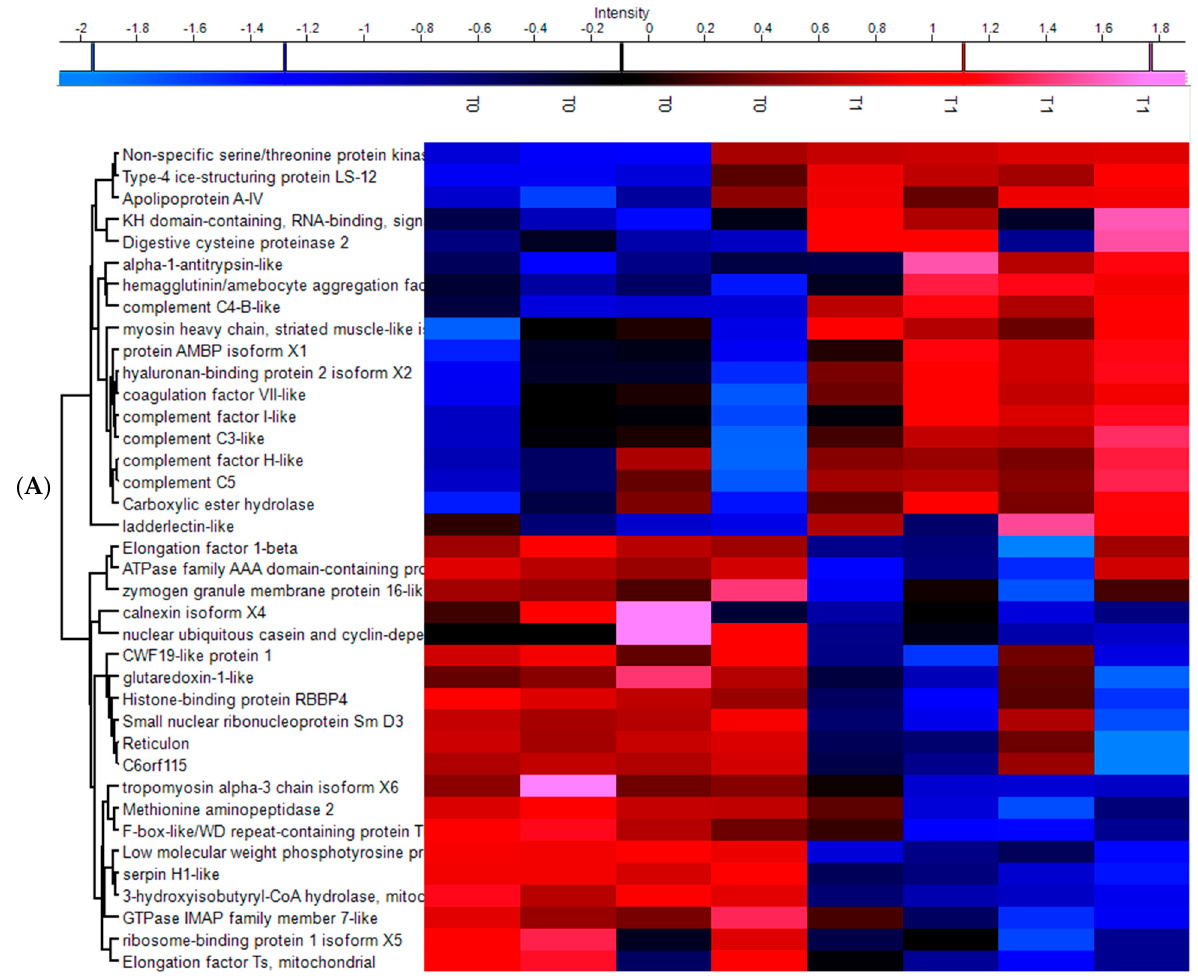
Table 1. Immune-related proteins differentially expressed in the gills of P. perurans inoculated salmon after freshwater treatment for initial P. perurans infection (T1) and at three timepoints post re-infection (T2, T3, and T4). Proteins were identified by mass spectrometry and analysis was performed by Max Quant and Perseus computational platforms. For each time point protein expressions were compared to naïve controls (T0). Reported fold change values were obtained by calculating the difference between the mean log 2 transformed values for the two compared conditions ( p value < 0.05).